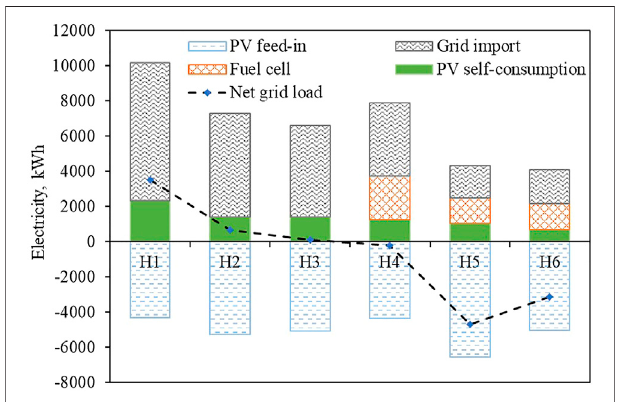
FIGURE 13 | Comparison of real ZEHs ’ annual net electricity balance between house and